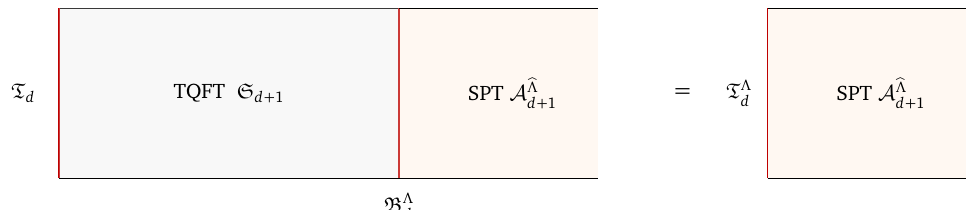
Figure 3: A polarization Λ is associated to a topological interface (that we refer to as a “boundary condition”) between the TQFT S and an SPT phase A (cid:98) Λ . A d + 1 d + 1 compactification of the TQFT S on a segment with the relative theory T at one d + 1 d end and B Λ at the other end, leads to the absolute theory T Λ , which comes attached d d to the SPT phase A (cid:98) Λ . The SPT phase captures the ’t Hooft anomaly of the higher- d + 1 form symmetry (cid:98) Λ of the absolute theory T Λ . d